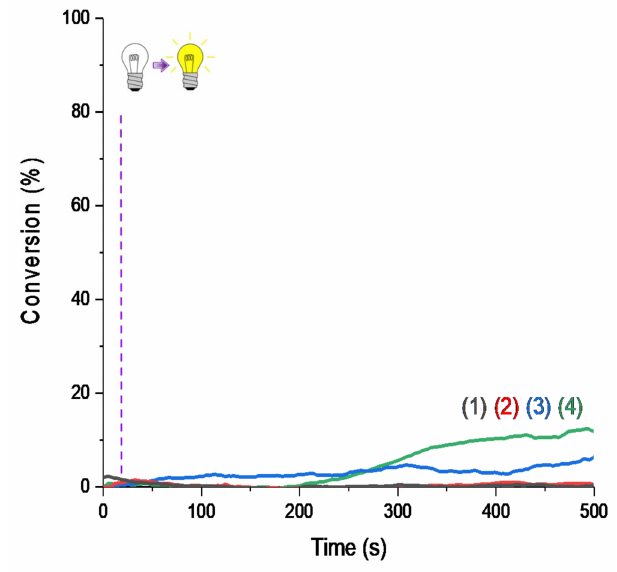
Figure 4. RT-FTIR polymerization profiles (C = C conversion of Mix-MA resin vs. irradiation time upon LED@405 nm) in the presence of (1) monomer alone; (2) Ar 2 I + / PF 6 − (1.5 wt%); (3) 4-dppba (0.5 wt%); and (4) Ar 2 I + / PF 6 − (1.5 wt%) and 4-dppba (0.5 wt%) and LED@405 nm; thickness = 1.4 mm, under air, irradiation starts after 10 s.